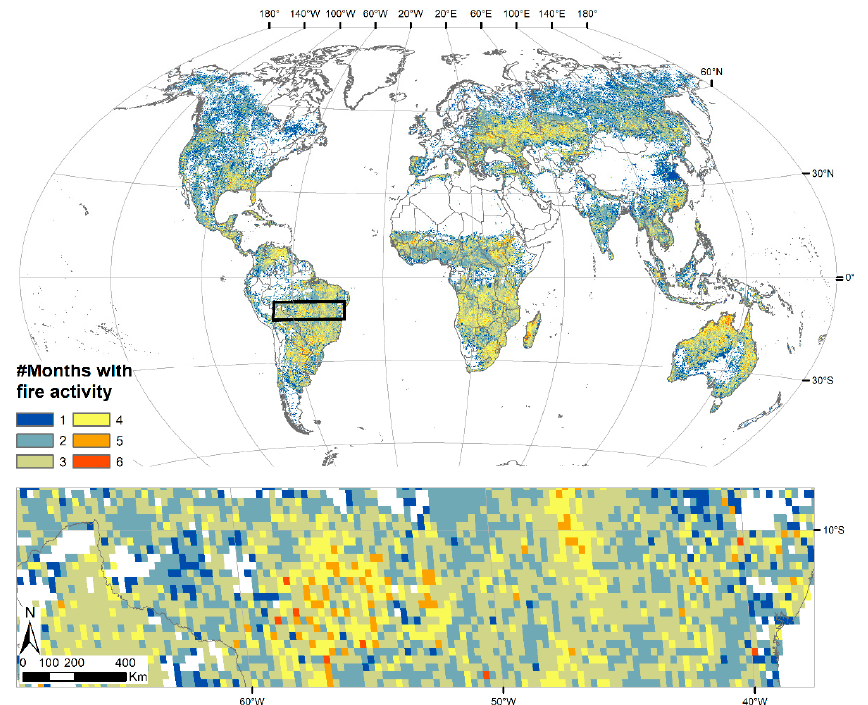
Figure A4. Spatial distribution of length of the fire season, expressed as number of months with significant fire activity (see main text for definition and further details). The bottom panel shows a zoomed region in central South America, as delineated in the global map.